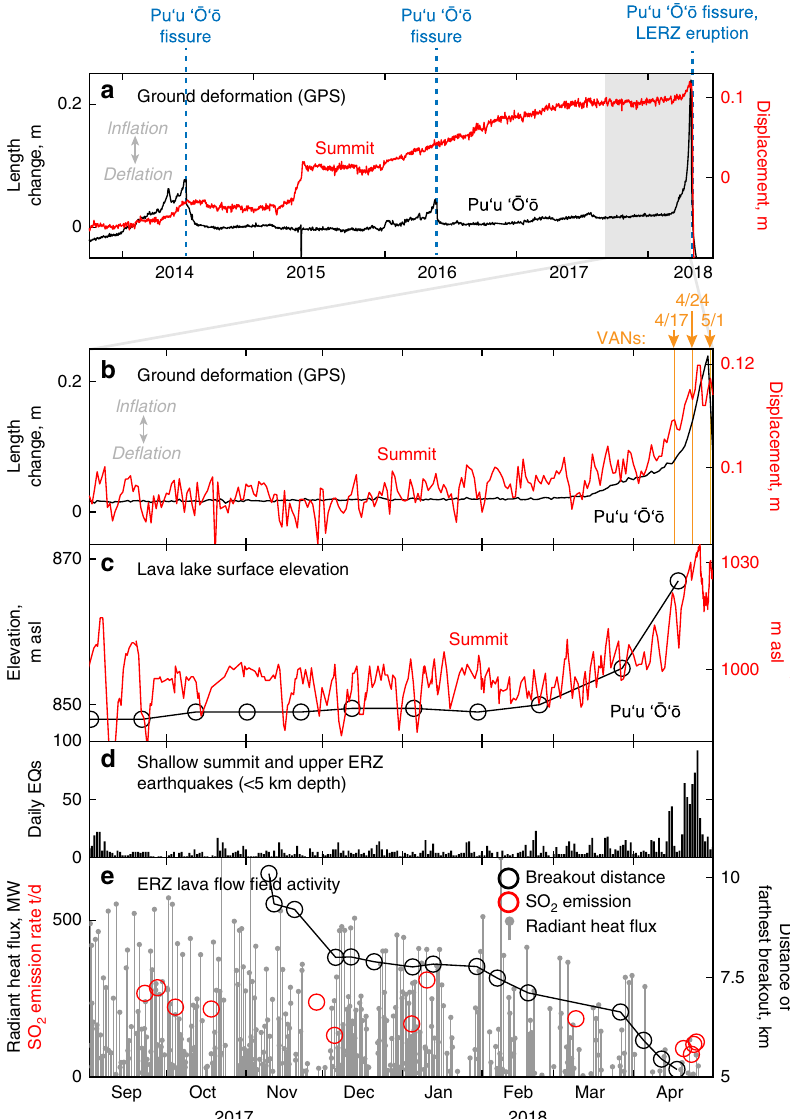
Fig. 4 Short-term changes preceding the 2018 eruption. a Displacement of summit and Pu ʻ u ʻ Ō ʻ ō GPS, 2013 – 2018 showing the 2014, 2016, and 2018 vent openings. The 2014 and 2016 vents opened on Pu ʻ u ʻ Ō ʻ ō , while in 2018 a minor vent opened on Pu ʻ u ʻ Ō ʻ ō but was followed by a larger eruption on the lower East Rift Zone (LERZ). b Displacement of summit and Pu ʻ u ʻ Ō ʻ ō GPS from September 2017 to April 30, 2018, showing in fl ationary changes starting in March 2018. “ VANs ” shows the dates of Volcanic Activity Notices issued by HVO; the April 17 VAN noted the ongoing pressurization and forecast that a new vent could form on the East Rift Zone (ERZ), while the May 1 VAN noted magma moving east of Pu ʻ u ʻ Ō ʻ ō and forecast that a vent could form downrift. c Surface elevation of the lava lakes at the summit and Pu ʻ u ʻ Ō ʻ ō , showing an abrupt rise in March – April. d Shallow (<5 km depth) summit and upper ERZ earthquakes, which commonly increase in rate during summit pressurization. e Indicators of fl ow activity on the Pu ʻ u ʻ Ō ʻ ō fl ow fi eld. “ Breakout distance ” shows the distance of the farthest surface lava breakouts from the Pu ʻ u ʻ Ō ʻ ō vent, measured along-tube, and shows a gradual retreat of breakouts upslope from November 2017 to April 2018. MODVOLC radiant heat fl ux, an indicator of surface fl ow activity, also decreased by April. SO 2 emissions from Pu ʻ u ʻ Ō ʻ ō exhibited unusually low values in